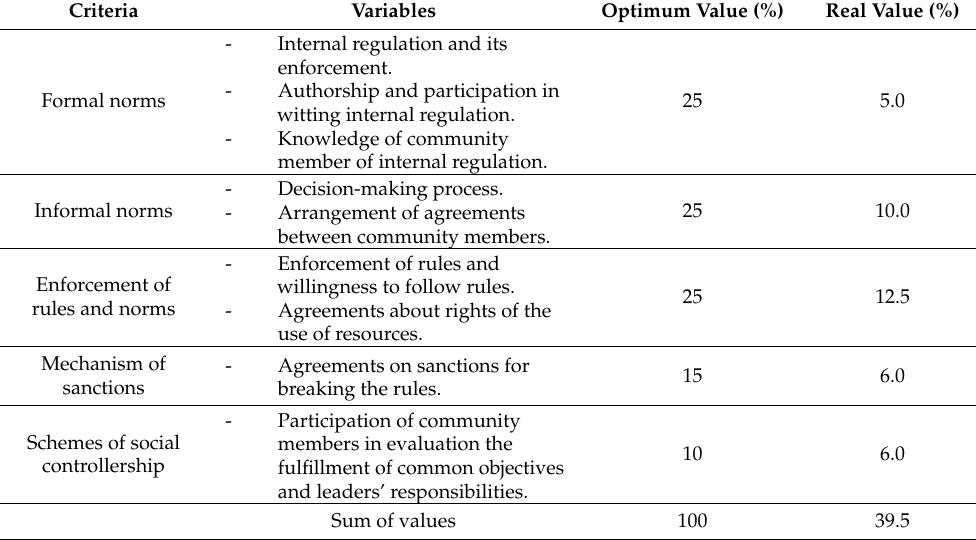
Table 8. Evaluation of specific indicators of collective action as part of community forest governance at San Miguel